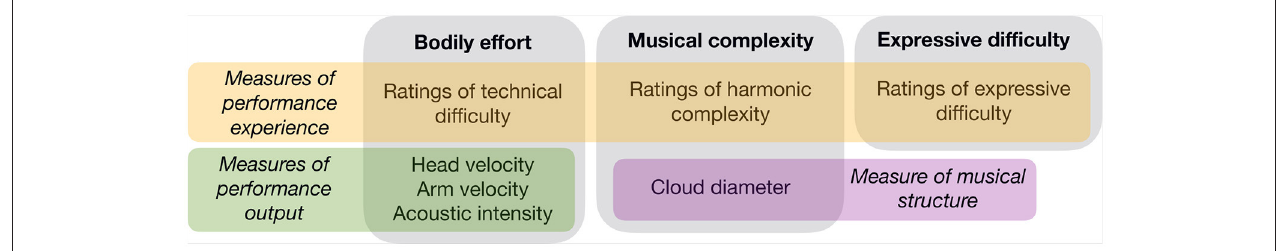
FIGURE 1 | List of predictors relating to bodily effort, musical complexity, and expressive difficulty.